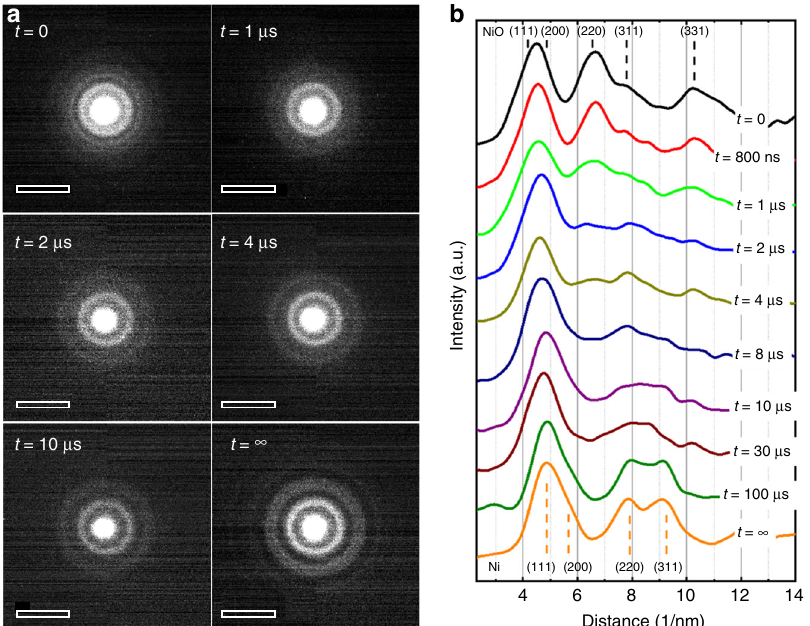
Fig. 4 Time-resolved electron diffraction. Single-shot electron diffraction patterns taken from the layer system at different times after the laser excitation; a shows a panel of the diffraction patterns and b shows the radial pro fi le through the patterns. The indexing of the peaks is given for NiO (top) and Ni (bottom). Scale bars in a : (10 nm) − 1